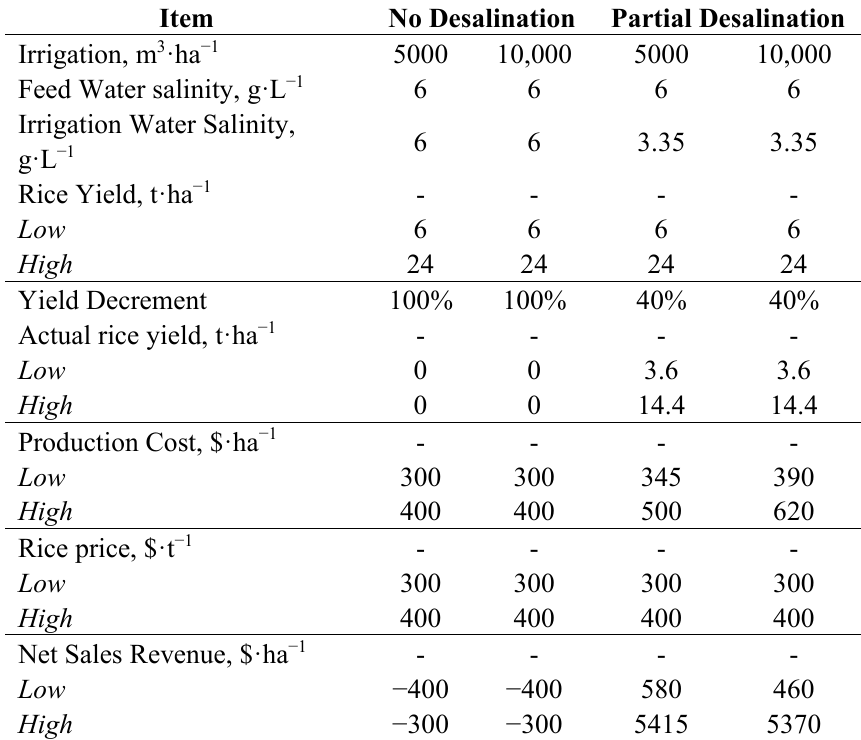
Table 7. Potential impact of partial desalination on the economics of rice cultivation. Assumptions: ZVM TPA (Trial E146); Desalination determination: Figure 20.